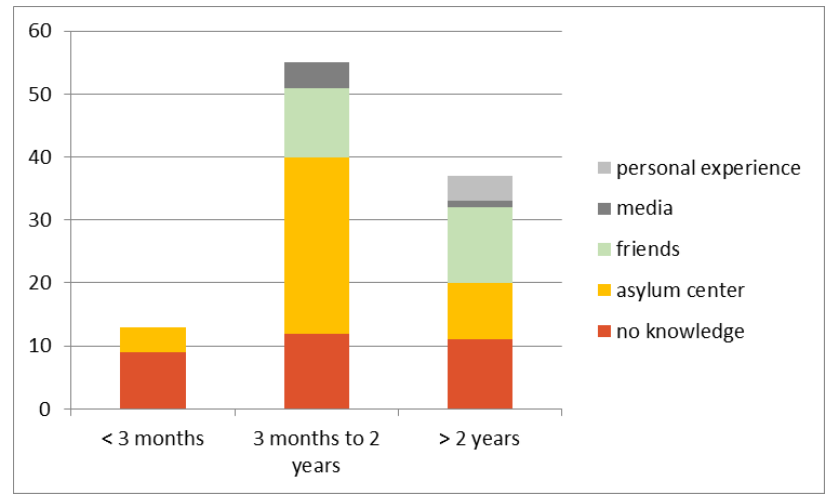
Figure 2. Health literacy of asylum seekers and source of knowledge of the Swiss health care system (HCS), dependent on the length of stay in Switzerland, total numbers (missing answers: 1).